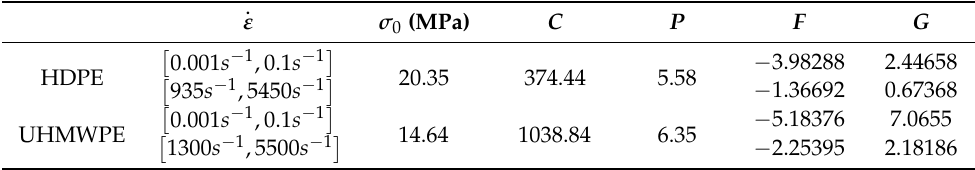
Table 4. Parameters of the constitutive model.